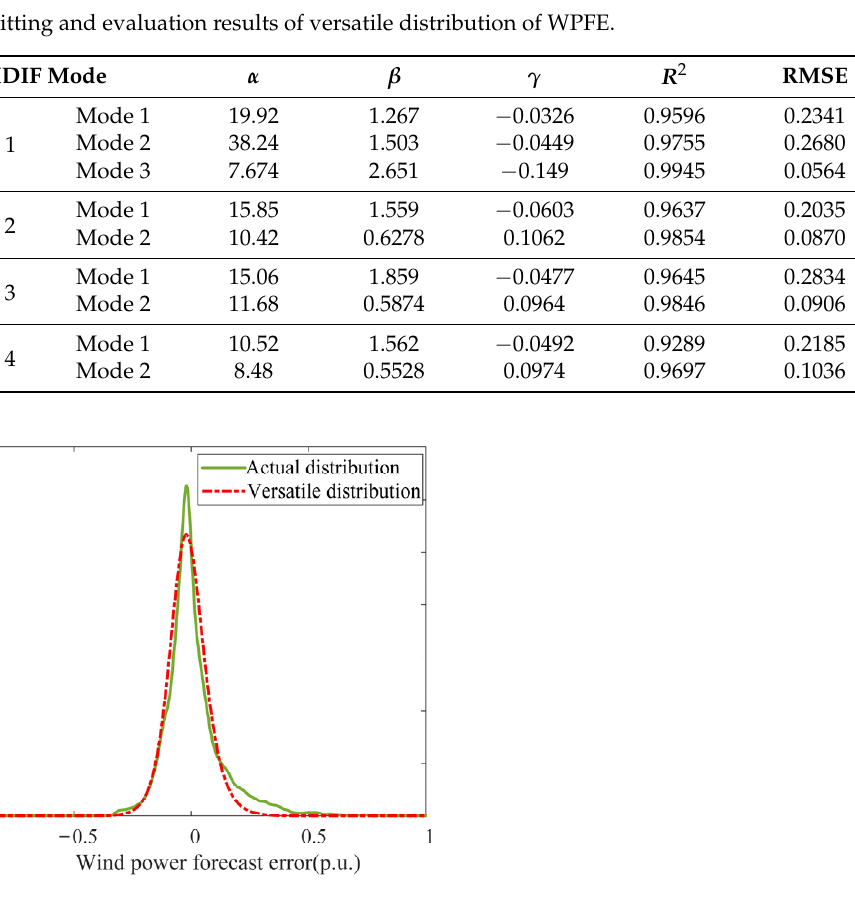
Figure 9. PDF curves of versatile distribution and actual distribution of WPFE in season 1, mode 1. Table 2. Fitting and evaluation results of versatile distribution of WPFE.